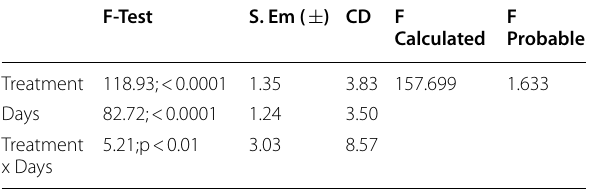
S. Em standard error of mean; CD critical difference